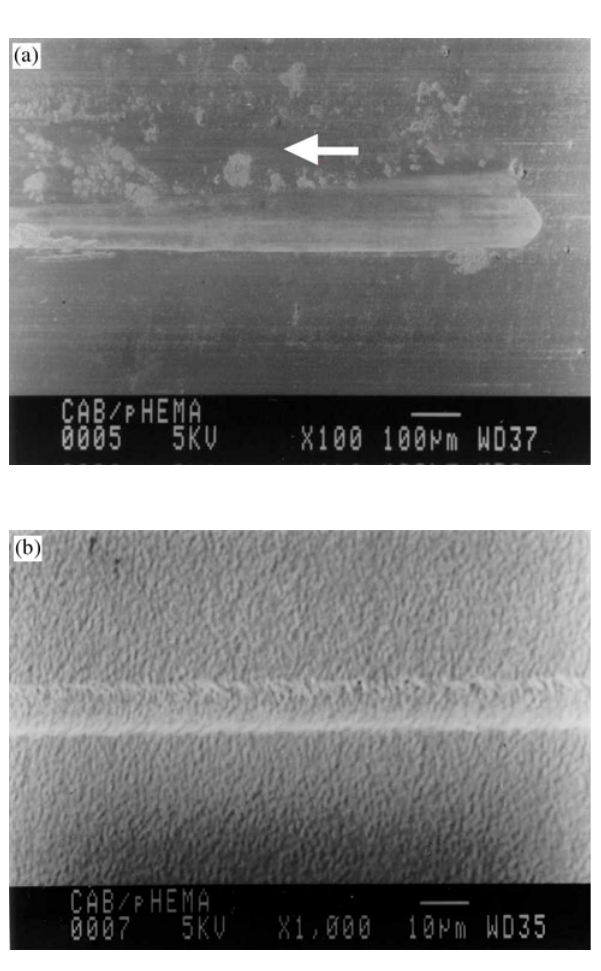
Figure 3. SEM from the worn surface of the pHEMA-CAB blend,